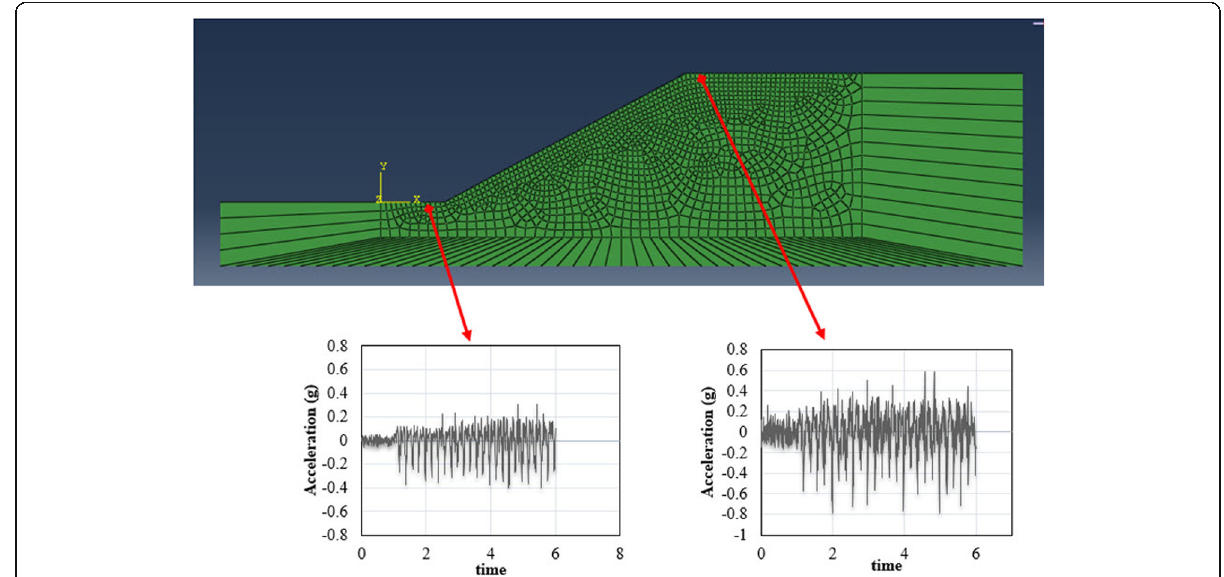
Fig. 21 Validation analysis of ABAQUS